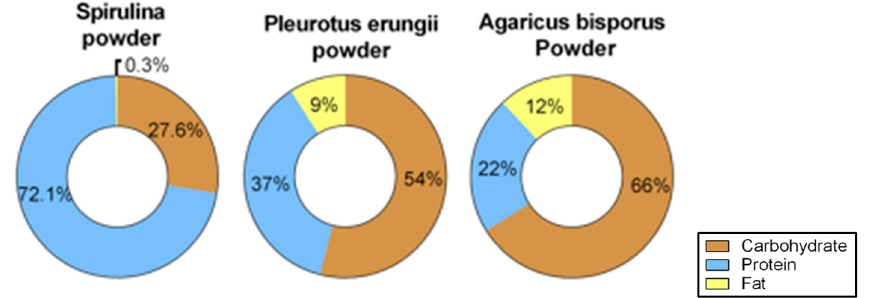
Figure 4. Macronutrient’s composition . Caloric distribution percentage of macronutrients in the three supplements .